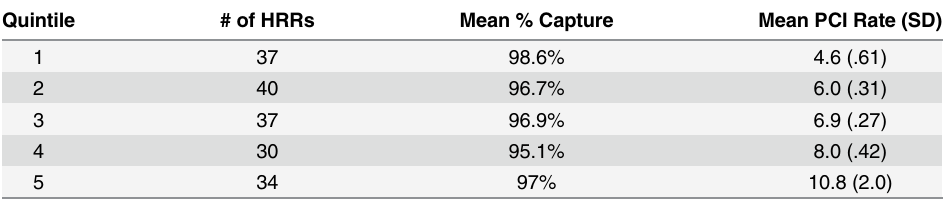
Table 1. Mean PCI rates within each quintile of utilization (per 1000).